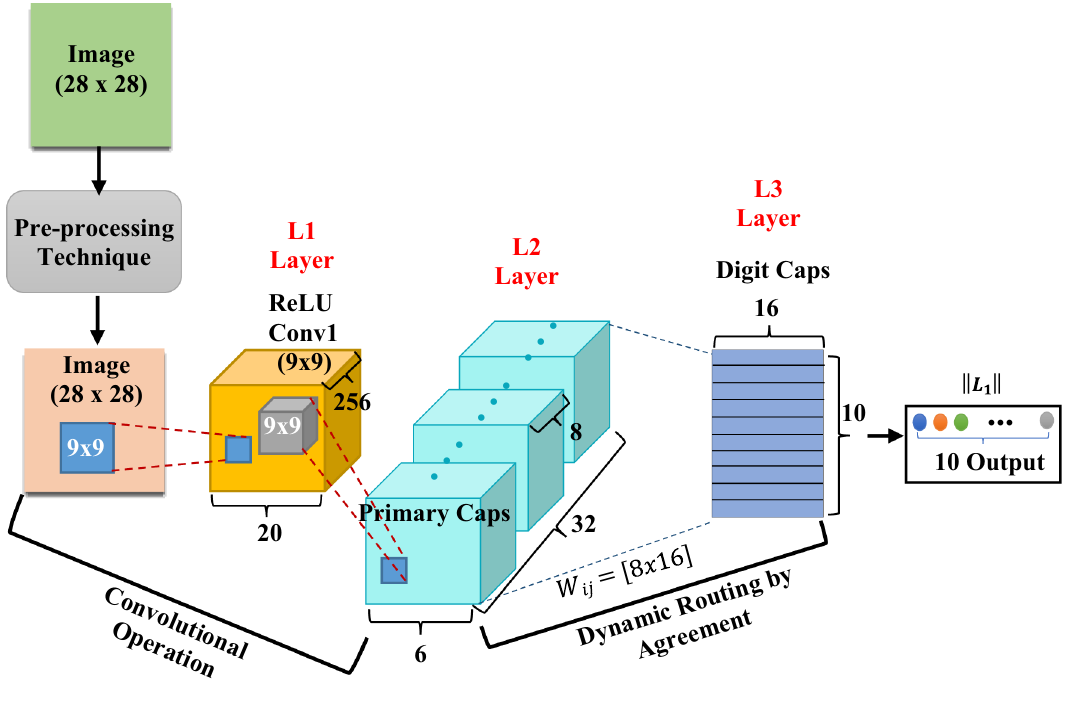
8-dimensional capsules. L3 Layer: Fully-connected with 16-D cap- sules. The number of capsules is 10. Note that we have dynamic routing only between the PrimaryCaps and DigitCaps